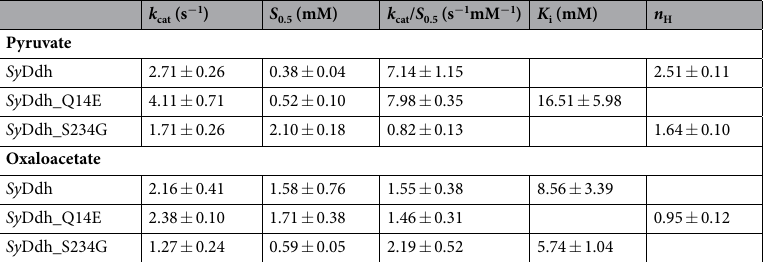
Table 1. Kinetic parameters of Sy Ddhs for pyruvate and oxaloacetate at 30 °C and pH 7.5. Parameters were calculated as described in the Materials and Methods. k cat , S 0.5 , and k cat / S 0.5 are the turnover rate, half-maximum concentration giving rise to 50% V max , and catalytic efficiency, respectively. The inhibition constant ( K i ) and Hill coefficient ( n